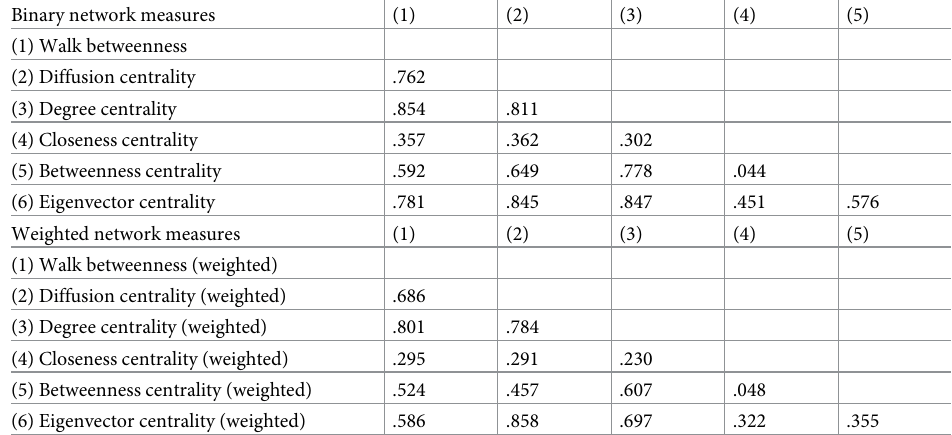
Table 4. Correlations across seven centrality measures among leader households in 75 Indiana villages. Binary network